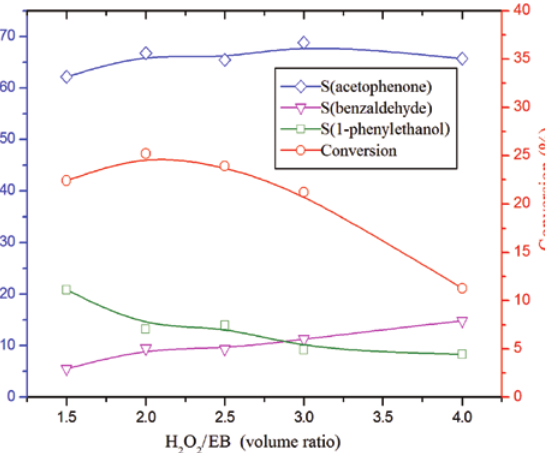
O /ethylbenzene volume ratio on the Figure 5: Effect of H 2 2 conversion and selectivities over activated carbon supported Co PW O (AC-CoPW) catalyst. Reaction conditions: T = 75 ° C; 1.5 12 40 P(CO ) = 5.5; tr = 7 h; m(cat) = 0.75 g and m (co-catalyst) = 0.25 g. 2